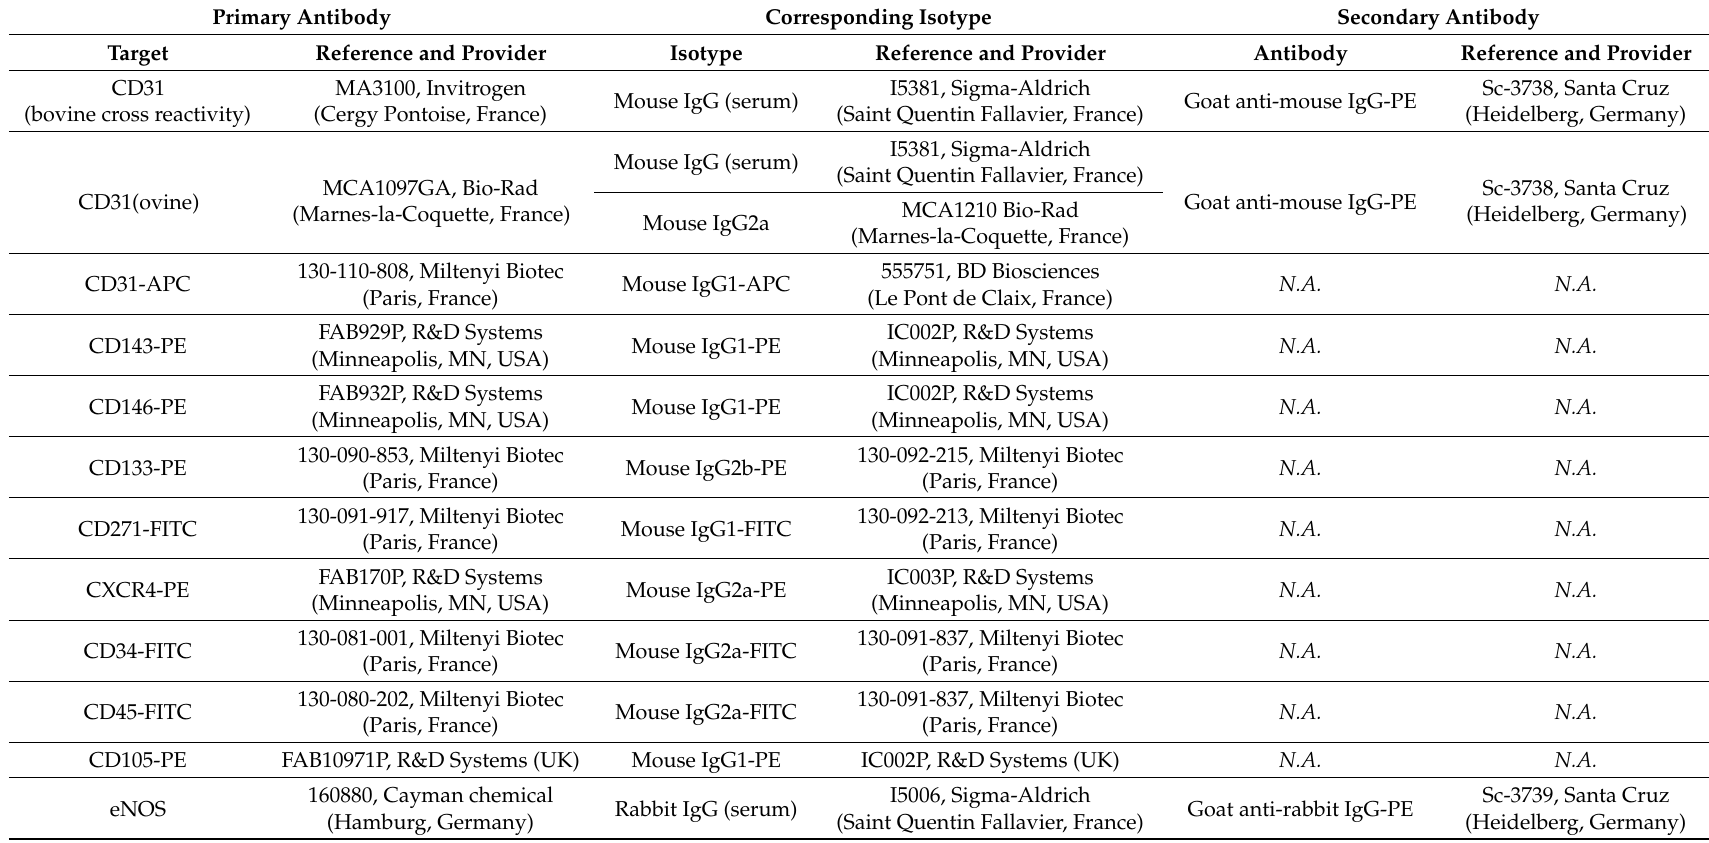
Table 6. Antibodies used for cell line characterization by flow